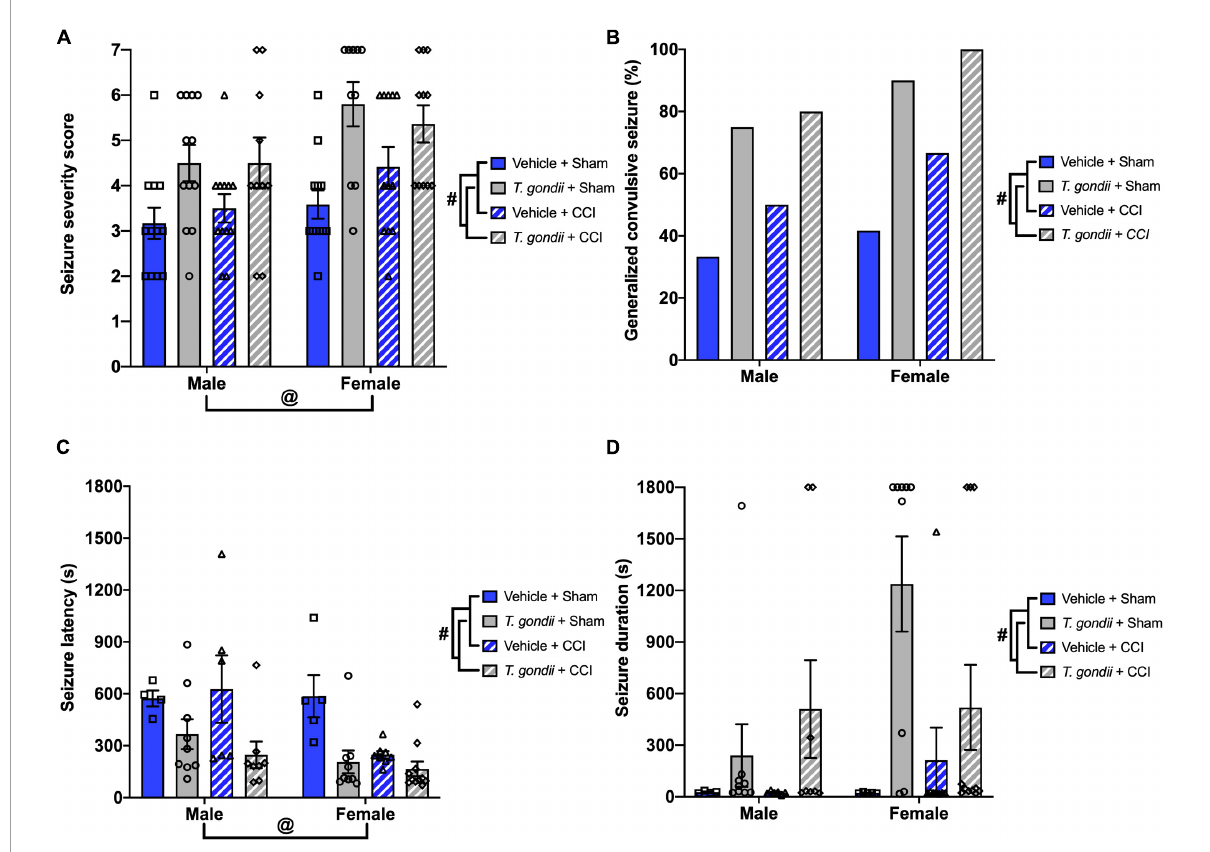
FIGURE3 Toxoplasma gondii infection increased chronic susceptibility to pentylenetetrazol (PTZ)-induced seizures irrespective of injury. (A) T. gondii and female mice reached higher seizure severity scores compared to vehicle and male groups, respectively. (B) Overall, a higher percentage of mice in T. gondii groups developed generalized convulsive seizures compared to vehicle groups, yet there was no difference between injured and sham groups. (C) Of the mice that exhibited a generalized convulsive seizure, female and T. gondii groups had decreased seizure latency. (D) In addition, T. gondii -infected mice had increased seizure duration compared to vehicle mice. # T. gondii -infected mice significantly differ from vehicle mice, @ female mice significantly differ from male mice, p < 0.05. n = 10–12/group/sex. Data shown is mean ± SEM.